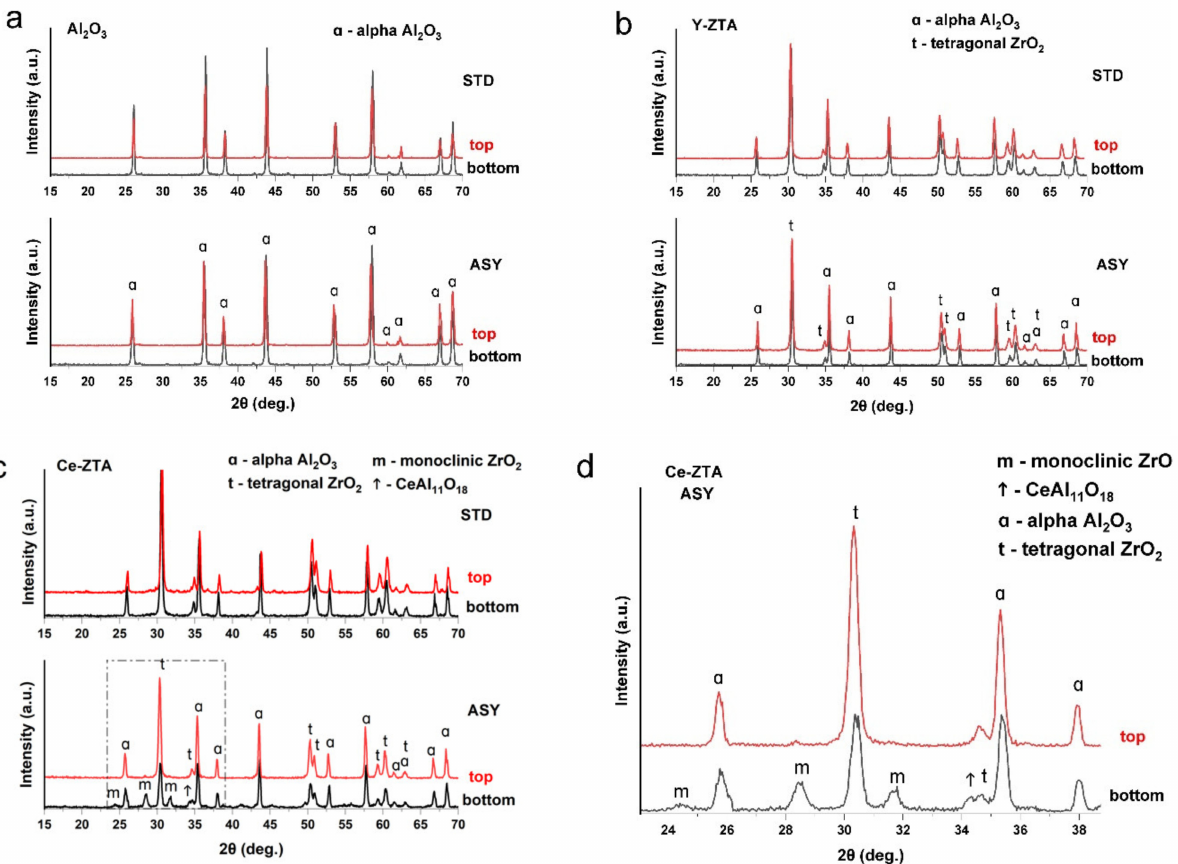
Figure 5. Phase composition of ( a ) Al 2 O 3 , ( b ) Y-ZTA, and ( c ) Ce-ZTA samples fabricated in STD and ASY modes at 1300 ◦ C. ( d ) Enlarged XRD pattern of the Ce-ZTA sample fabricated in ASY focusing on the phase differences between the top and bottom